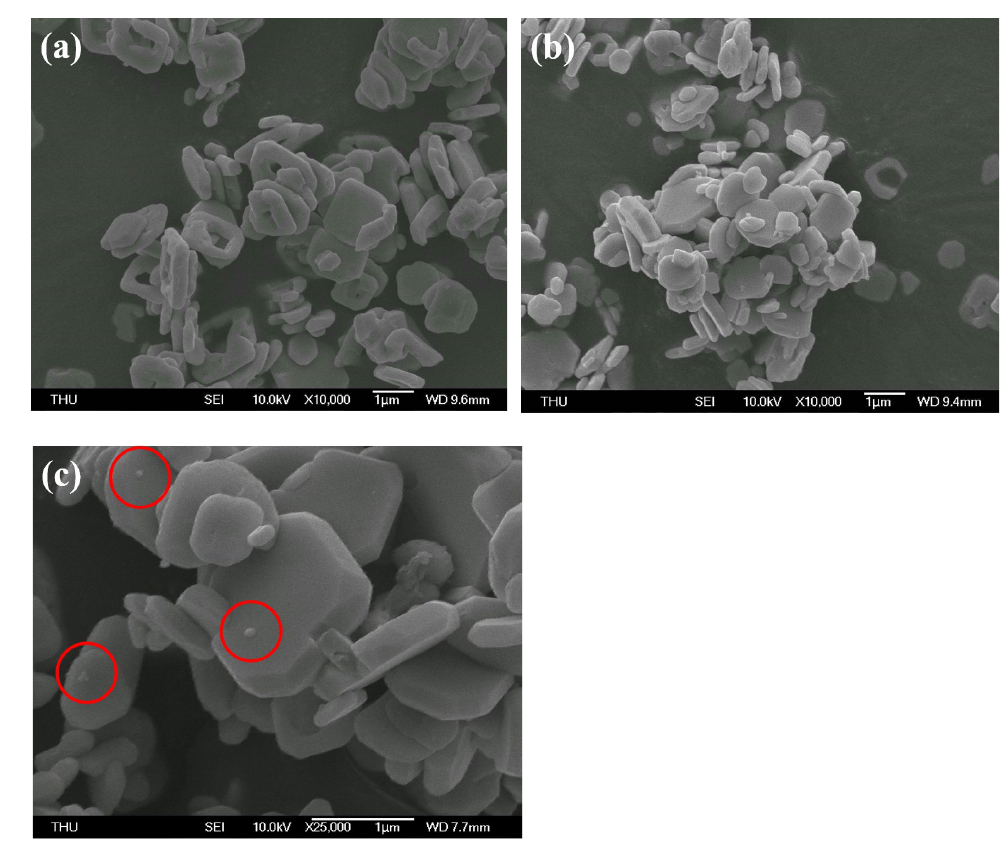
Figure 2. SEM images of the as-prepared ( a ) BiVO 4 , ( b ) 7% graphene/BiVO 4 , and ( c ) TAgNPt/Graphene/BiVO 4 with 0.003 wt% of TAgNPt and 7 wt% of graphene.